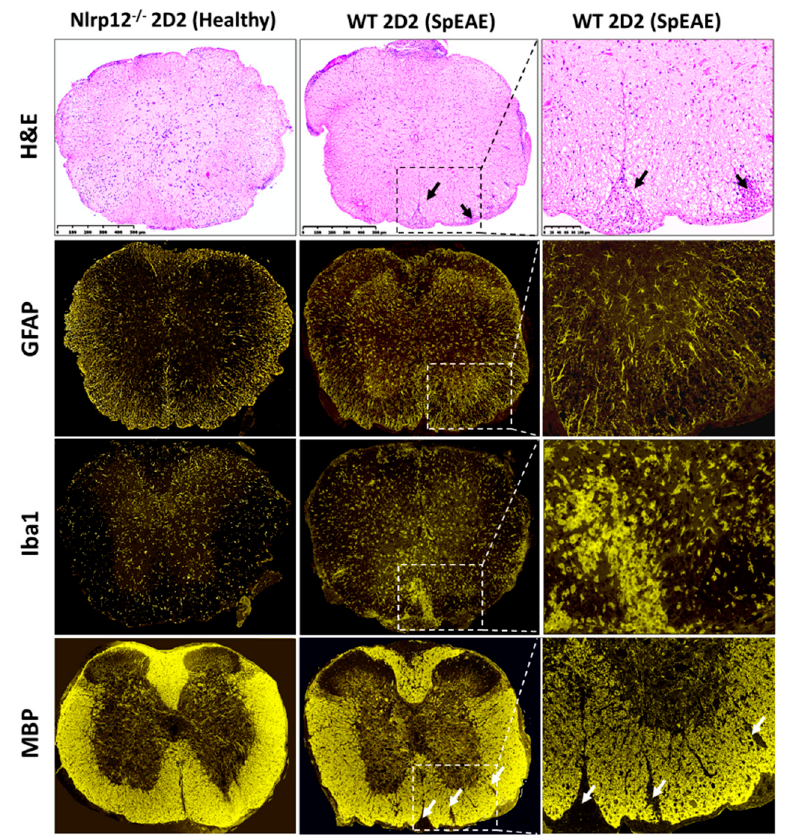
Figure 8. SpEAE in WT 2D2 mice is associated with spinal cord inflammation and demyelination. Representative histopathological examination of the spinal cords from healthy Nlrp12 − / − 2D2 mice and spEAE WT 2D2 mice. H&E staining reveals an extensive mononuclear cell infiltration to the spinal cord of spEAE mice (shown by black arrows). Immunofluorescent staining of spinal cords from WT 2D2 spEAE shows an increased expression of GFAP (astrocyte marker) and Iba1 (macrophage/microglia marker) mice compared to Nlrp12 − / − 2D2 healthy mice. Focal demyelinating lesions (shown by white arrows) are observed in spEAE spinal cords using MBP staining. Similar histopathological features to healthy Nlrp12 − / − 2D2 mice were found in healthy WT 2D2 mice (images not shown).